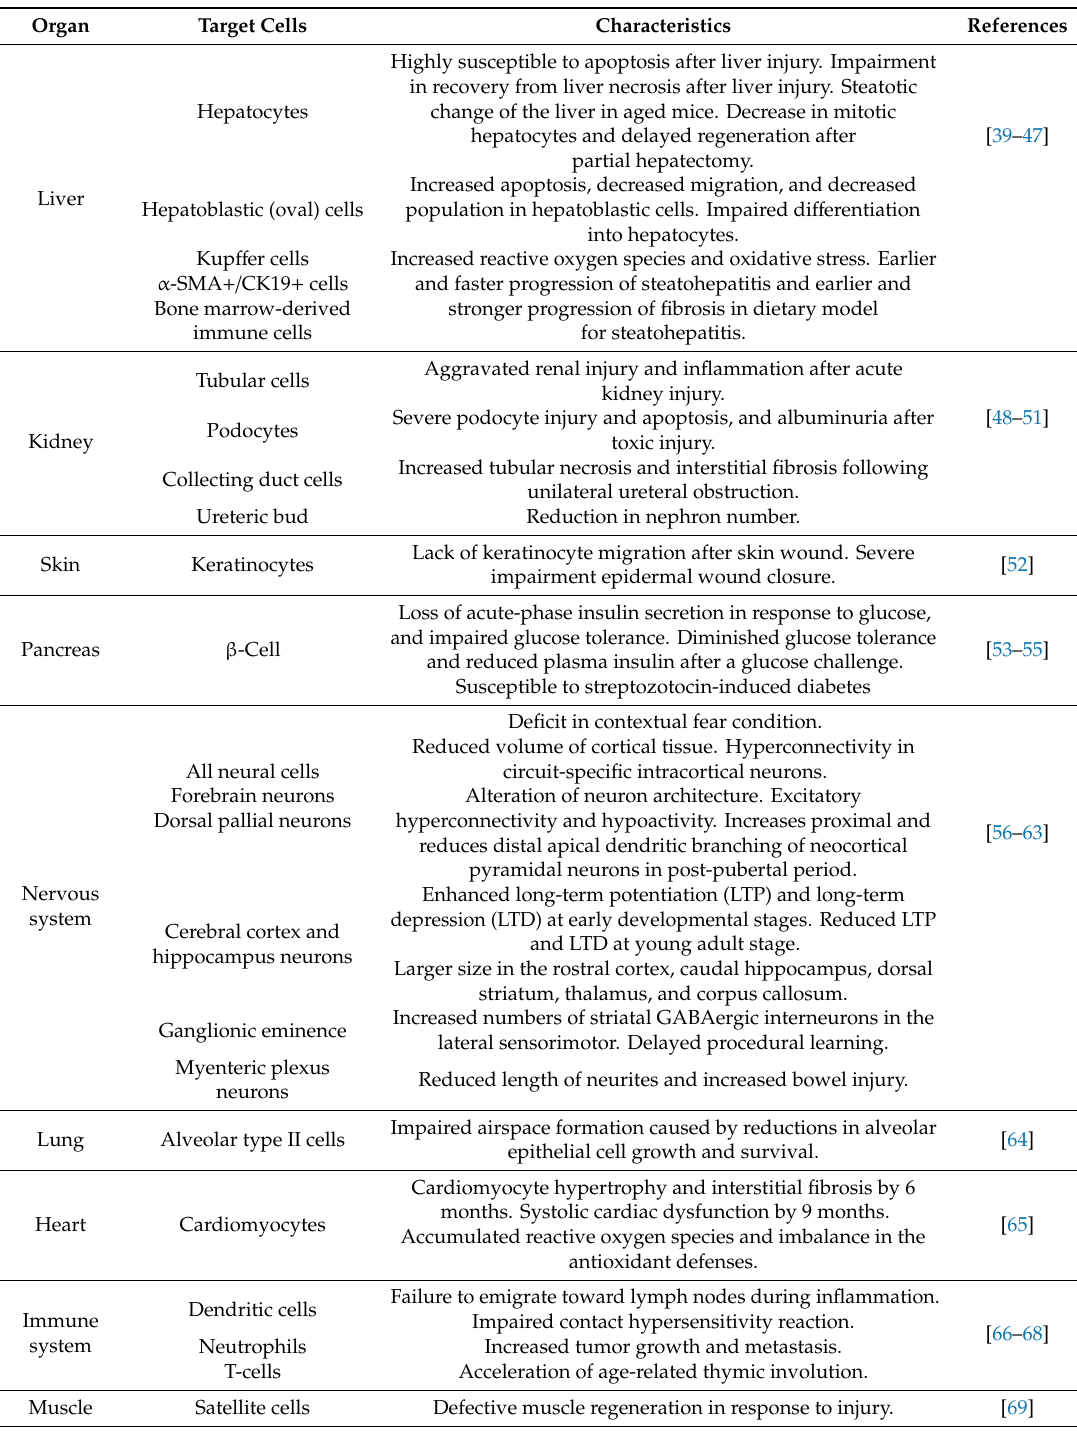
Table 1. Characteristics of Conditional MET Knockout